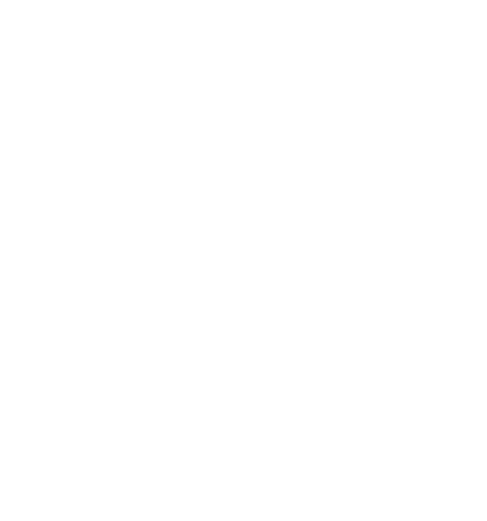
Figure 5. Descriptive anteroposterior (AP) measurements of the vertebral endplates in mm in our study population. S1 is smaller than L5, and L5 is smaller than L4. The 10% cutoff definition for disproportion is also displayed. Table 2. Summary statistics of the endplate measurements.